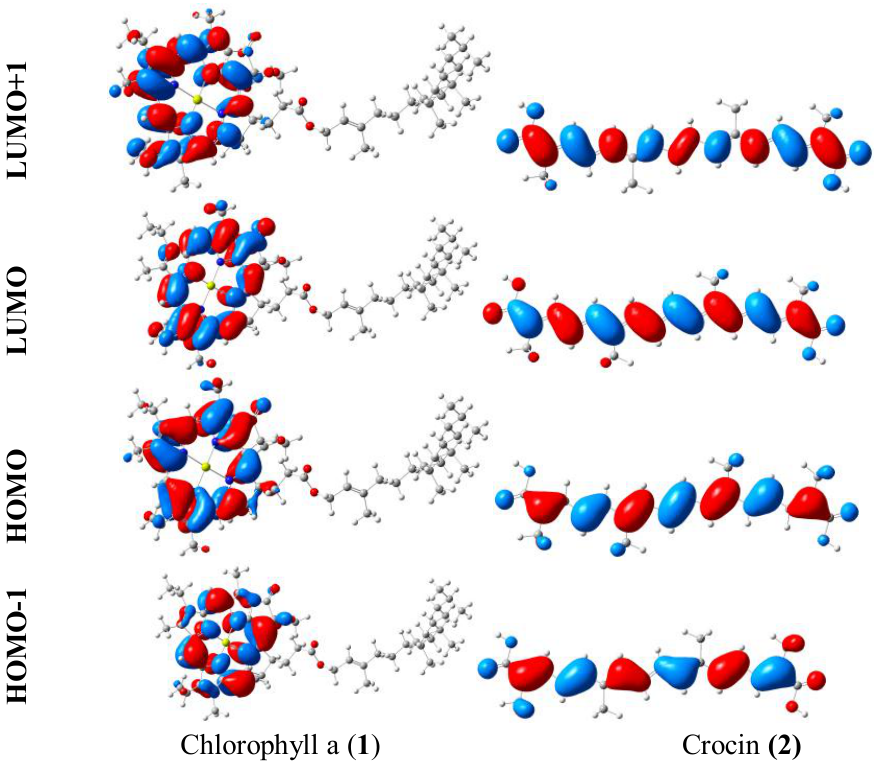
Figure 3: The frontier and second frontier molecular orbitals of Chlorophyll a (1) and Crocin (2) .